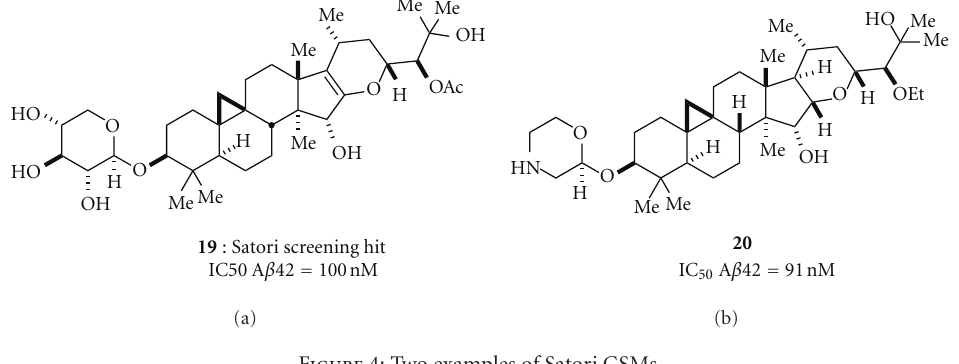
Figure 4: Two examples of Satori